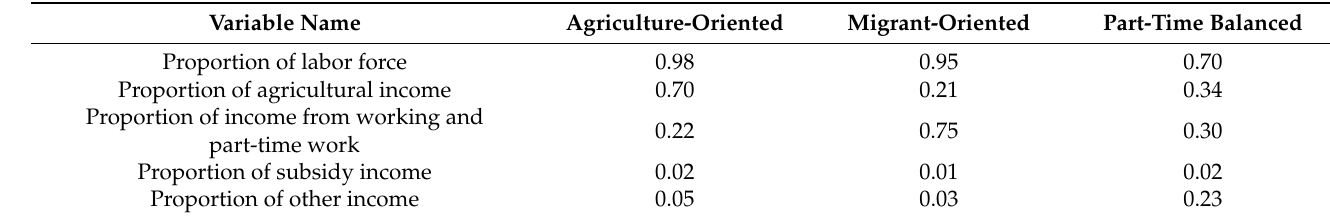
Table 5. Classification of livelihood strategies of resettled